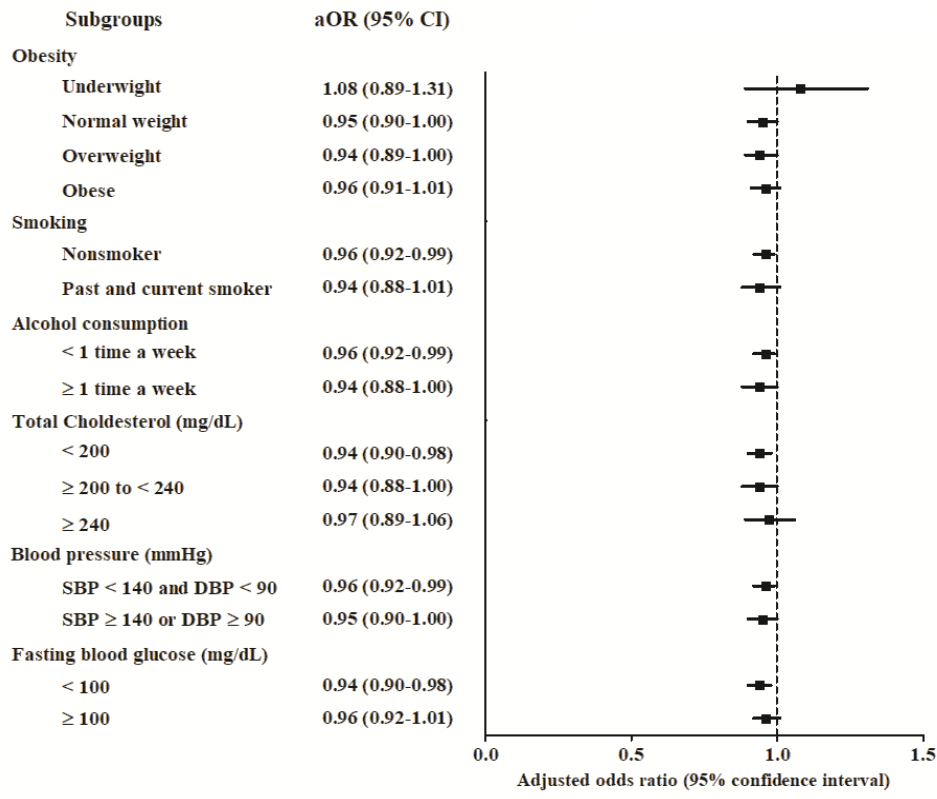
Figure 2. Adjusted odds ratios and 95% confidence intervals for the days of statin use per year in AD patients compared with control participants according to various comorbidities. AD—Alzheimer’s disease; CI—confidence interval; DBP—diastolic blood pressure; OR—odds ratio; SBP–systolic blood pressure.